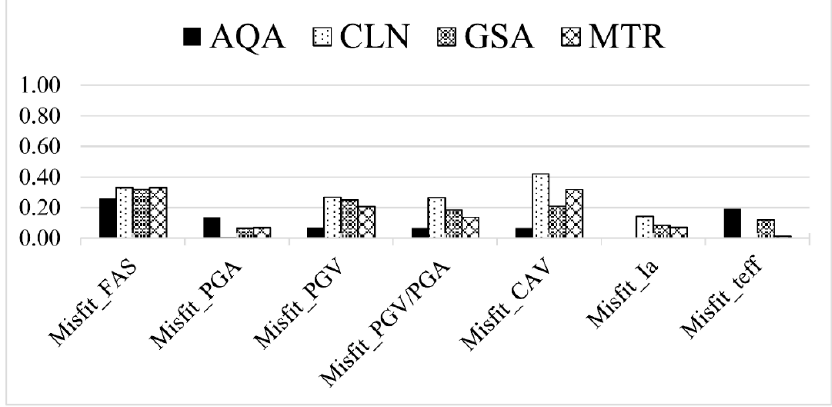
Figure 6. Station-wise seismological log-scale misfits between the real and simulated records of the L’Aquila event.